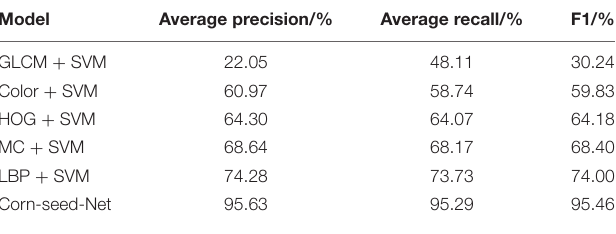
TABLE 5 | Comparison of object detection